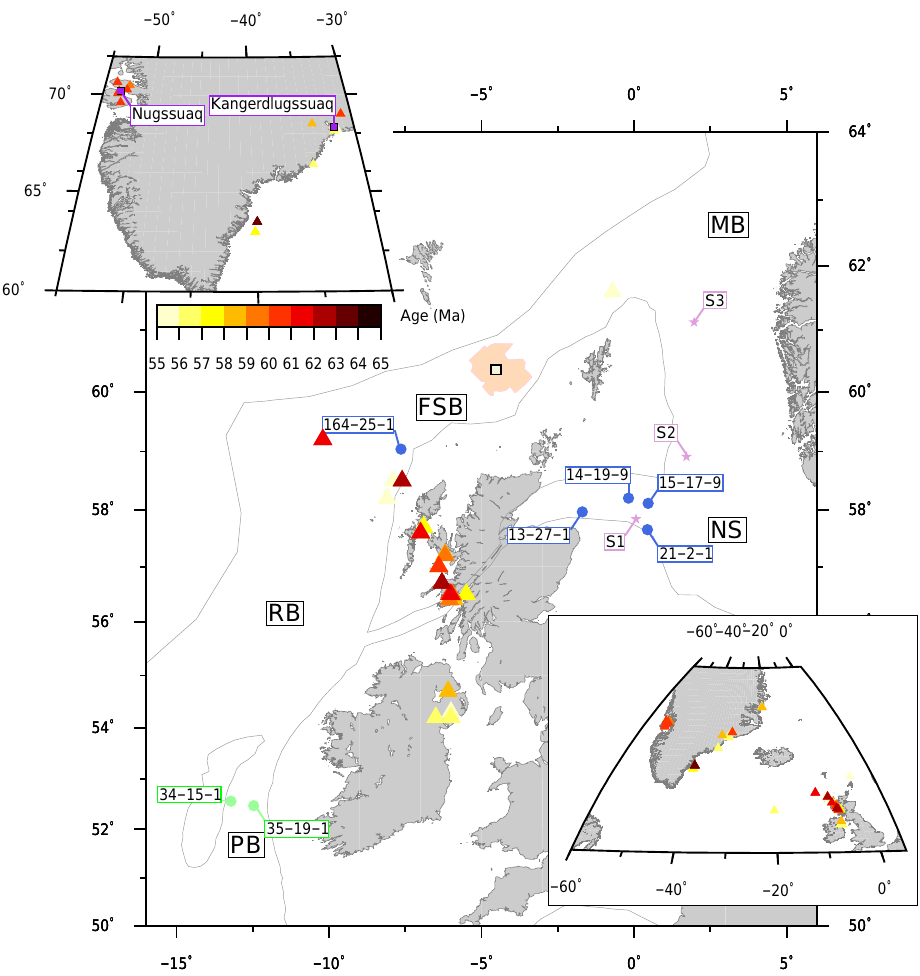
Figure 7. Map view locations of the compiled dataset used to compare against the evolution of model dynamic topography. Solid blue circles: locations of wells that were backstripped for their water-loaded tectonic subsidence histories in Clift and Turner (1998); solid green circles: locations of wells that were backstripped for their water-loaded tectonic subsidence histories in Jones et al. (2001); solid pink stars are locations of modelled stratigraphic cross sections from Nadin et al. (1997); solid beige region represents area of 3-D seismic data coverage used in the analytical modelling approaches of Hartley et al. (2012). Coloured triangles are age-coded plume-related extrusive volcanics from 55 to 65Ma only (taken from the compilation of Torsvik et al., 2001). MB: Møre Basin; FSB: Faroe–Shetland Basin; RB: Rockall Basin; PB: Porcupine Basin; NS: North Sea. Lower inset shows an overview of the northeastern Atlantic region and the distribution of age-coded plume-related extrusive volcanics. Upper inset shows two additional locations (purple squares) discussed in text on the eastern and western Greenland